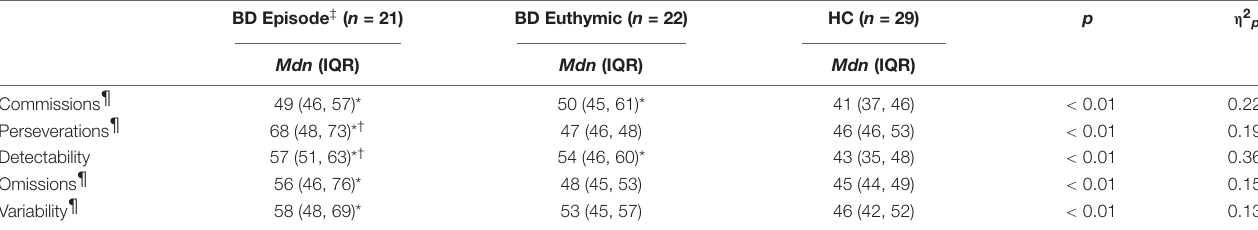
TABLE 2 | Results of the groups for continuous performance test.